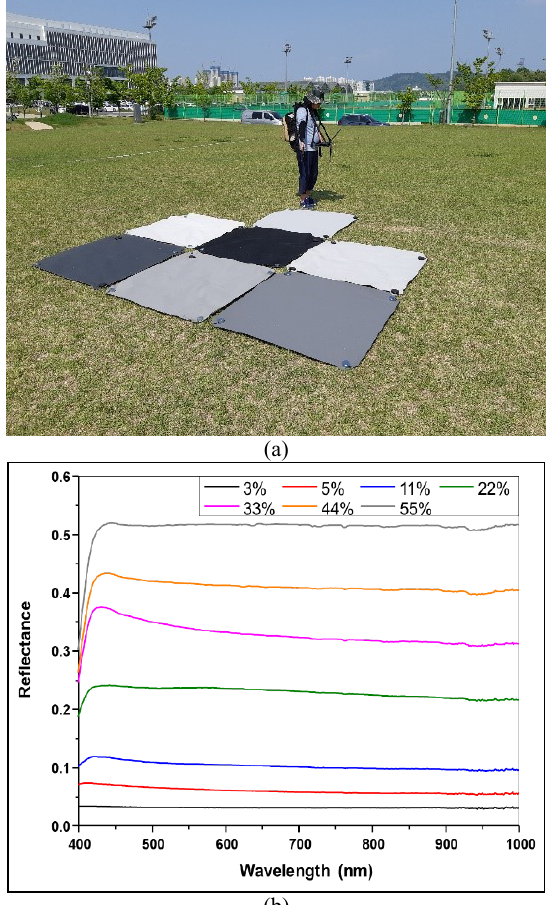
Figure 3. (a) Ground reference panels installed for